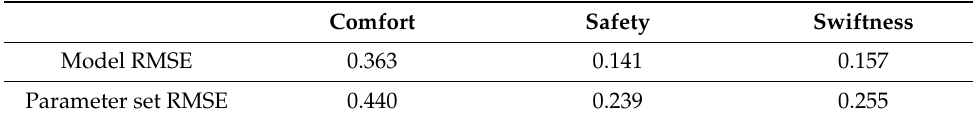
Table 5. Validation RMSE of the parameter set. Comfort Safety Swiftness Model